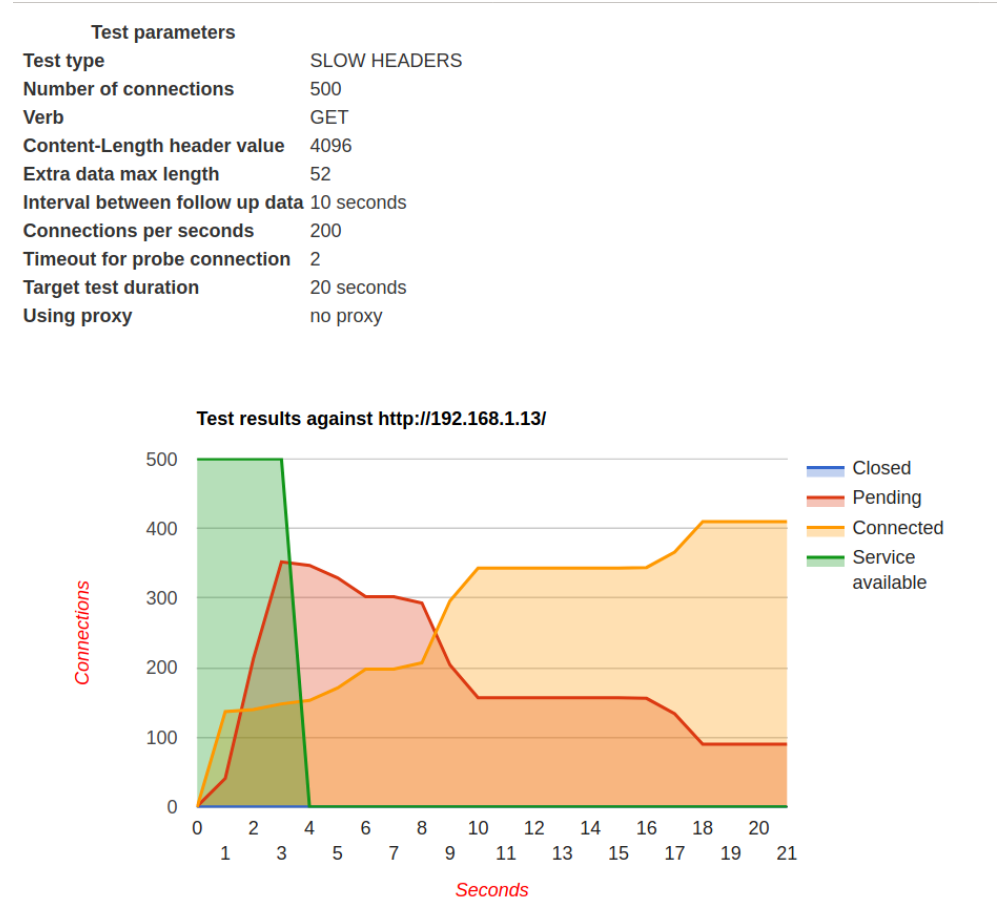
Figure 11. SlowHttpTest command line